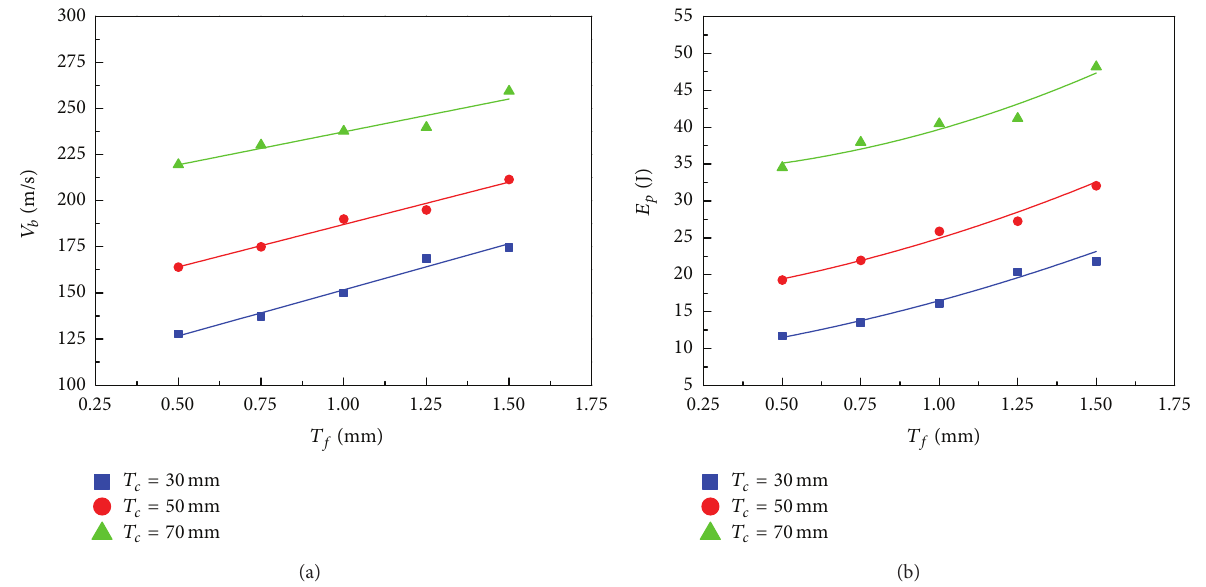
Figure 15: Effects of face-sheet thickness on (a) ballistic limit and (b) minimum perforation energy of the auxetic HSPs with three different core thicknesses ( 𝜌 = 0.15